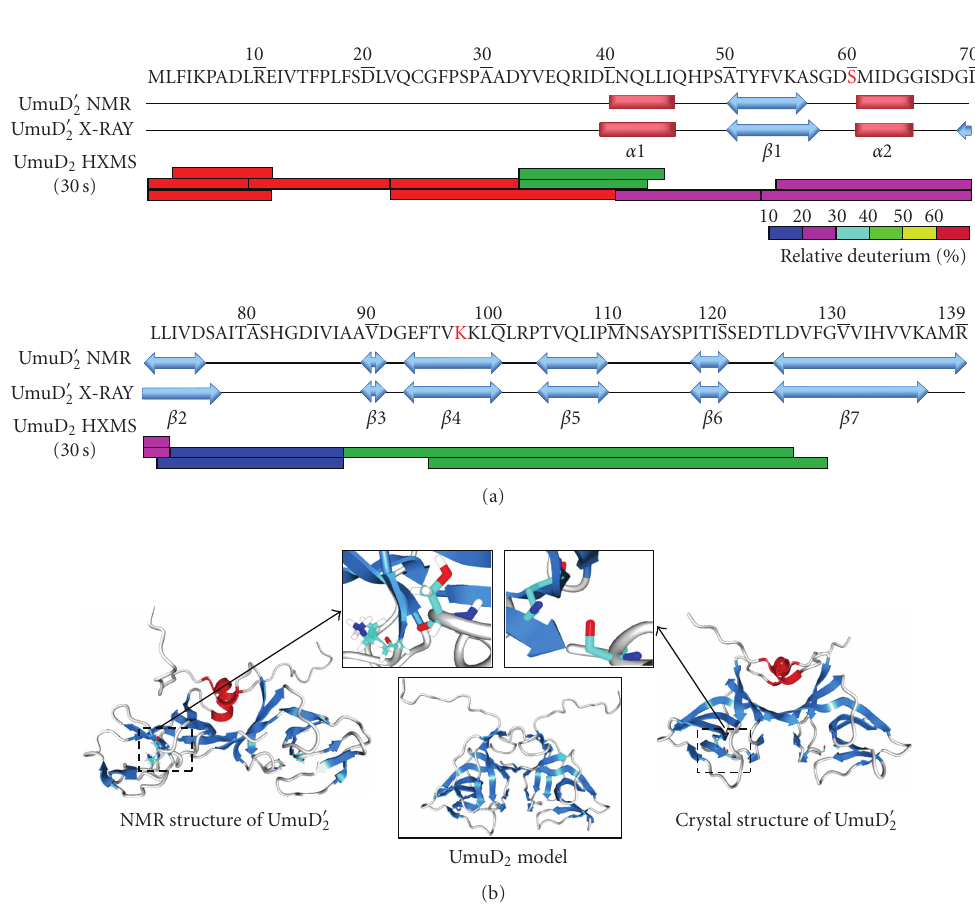
Figure 2: The secondary and tertiary structure of UmuD 2 and UmuD (cid:2) [44, 45] and crystal [46] structures. The α helices are shown in red, and β sheets are shown in blue. Relative deuterium incorporation of UmuD 2 at 30 sec labeling in HXMS experiments is shown, and the colors are based on the relative deuterium percentage scale shown [51]. (b) Comparison of the NMR [44, 45] and crystal [46] structures of UmuD (cid:2) The active site regions are boxed and shown in the insets. A model of full-length UmuD 2 is shown